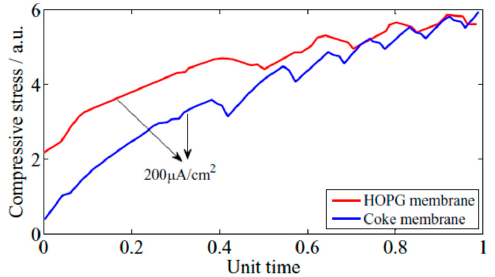
Figure 6. Stress evolution of three carbon electrodes during galvanostatic cycles at room temperature in different periods: 3000 s and 25,000 s for highly oriented pyrolytic graphite (HOPG) and coke membrane electrodes, respectively [26].